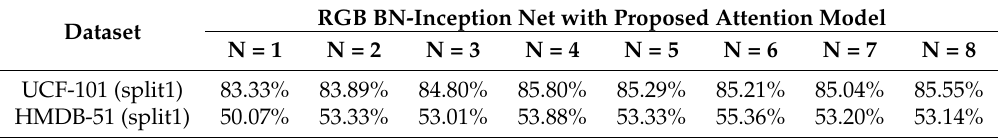
Table 3. Classification accuracies by choosing different total segment numbers ( N in Equation (1)) on a RGB image-based BN-Inception net with the proposed attention